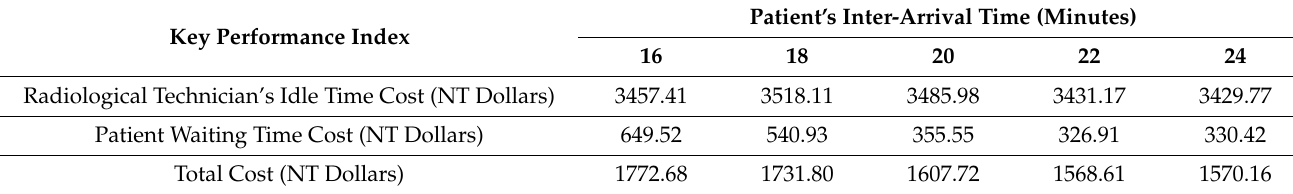
Table 14. Sensitivity analysis 1 with the pair cost coefficients (0.4, 0.6).